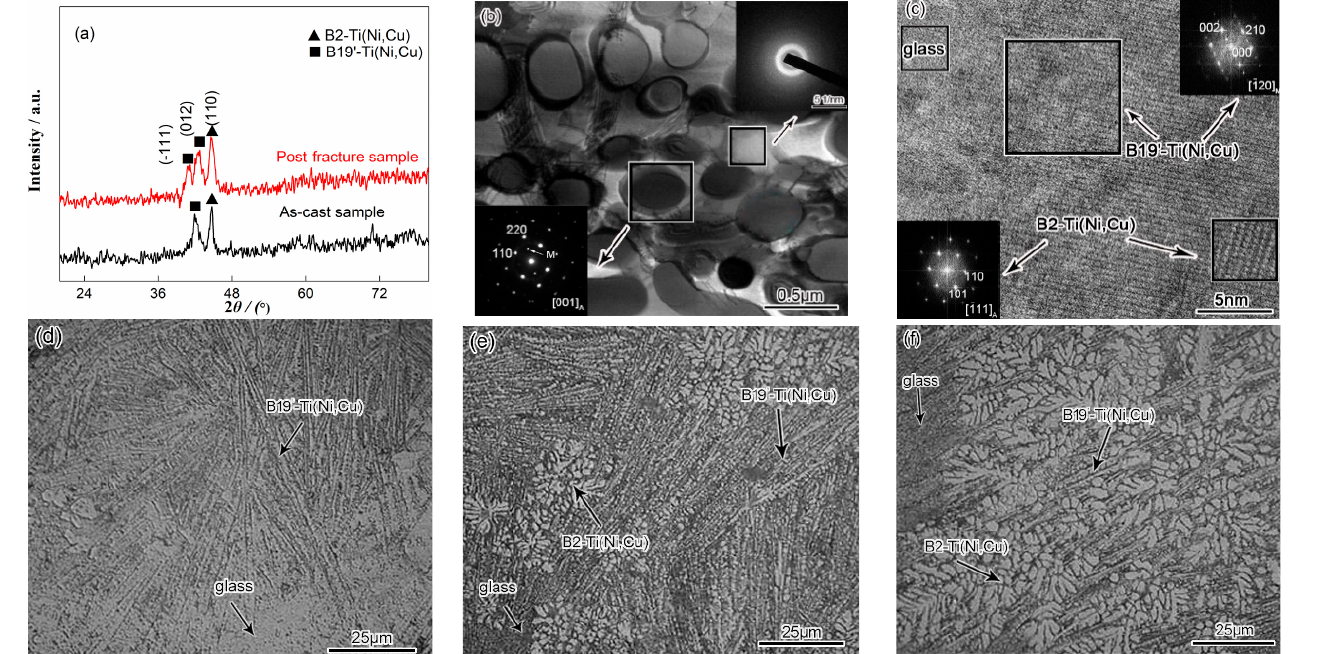
Figure 1. Microstructure of Φ 3 mm Ti 40 Ni 40 Cu 20 alloy. ( a ) XRD patterns of as-cast and post-fracture samples. ( b ) TEM and SADP of as-cast samples, dispersion halo ring and diffraction patterns confirm the amorphous and DSMC mixed structure. ( c ) High resolution transmission electron microscopy (HRTEM) and Fast Fourier transform (FFT) further certified the microstructure of DSMC BMGCs. ( d – f ) Optical microscope (OM) of the edge, transition and inner zones; ( d ) contains a more amorphous featureless phase, fine lath martensite and some small austenite plates; ( e ) contains more coarse lath martensite and some fine austenite dendrites, and a small amount of amorphous phase; ( f ) mostly contains the developed austenite dendrites, and little lath martensite and amorphous featureless phase.